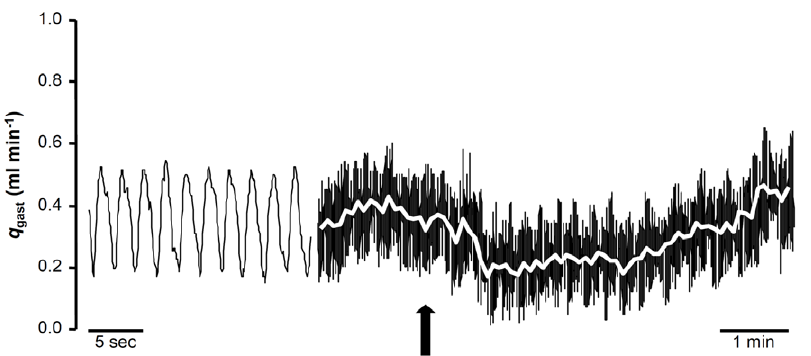
Figure 1. Representative gastrointestinal blood flow trace. The trace was recorded from a 120 g P. borchgrevinki at , 24 hours postprandial. Vertical arrow indicates when the experimenter taps on the respirometer provoking a precipitous reduction in blood flow that subsequently returns to baseline.